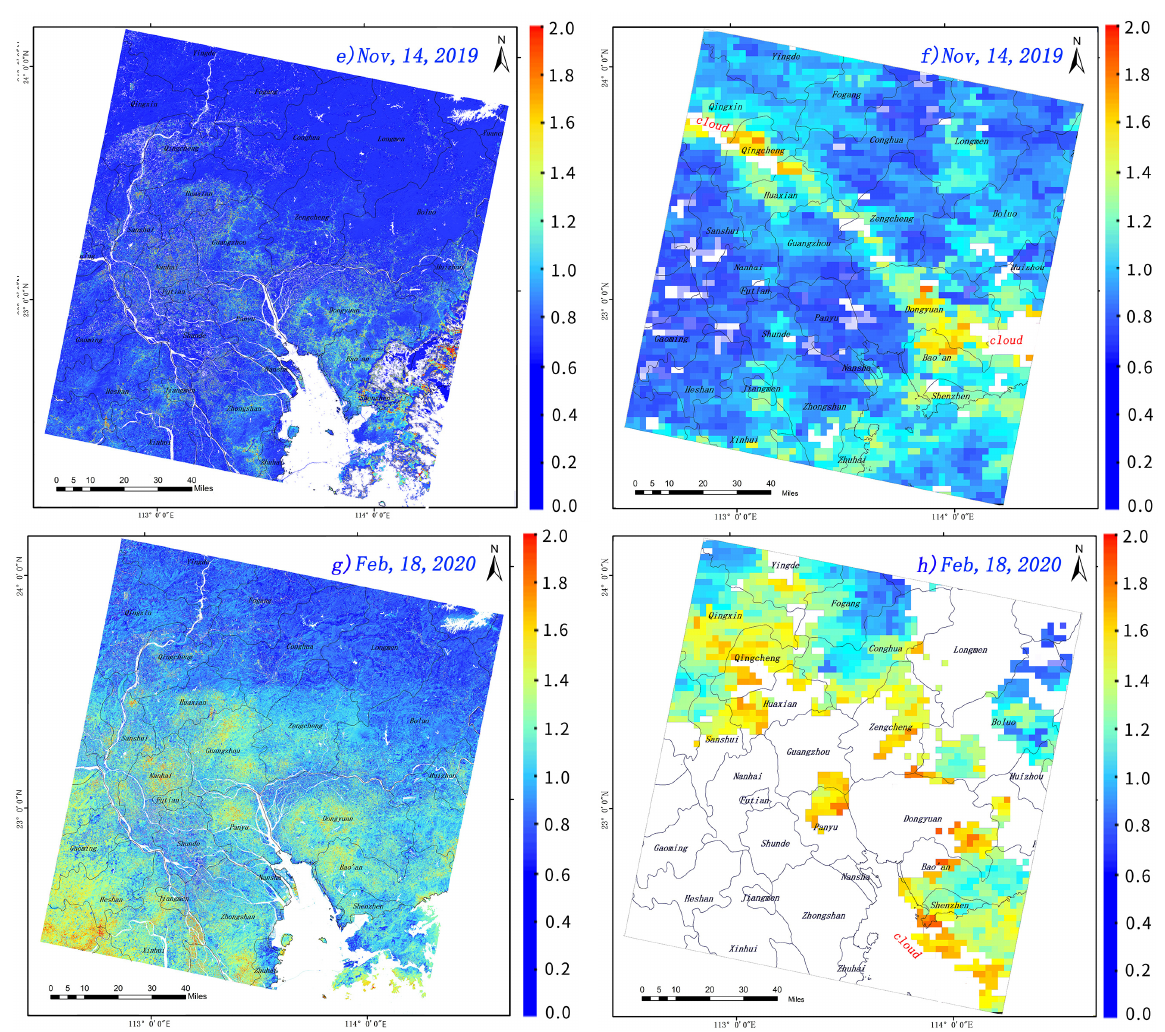
Figure 8. Spatial and temporal distribution of Landsat8 OLI AOD ( Left ) and MODO4 DB AOD at 3 km ( Right ) in the PRD for a certain day in different years.